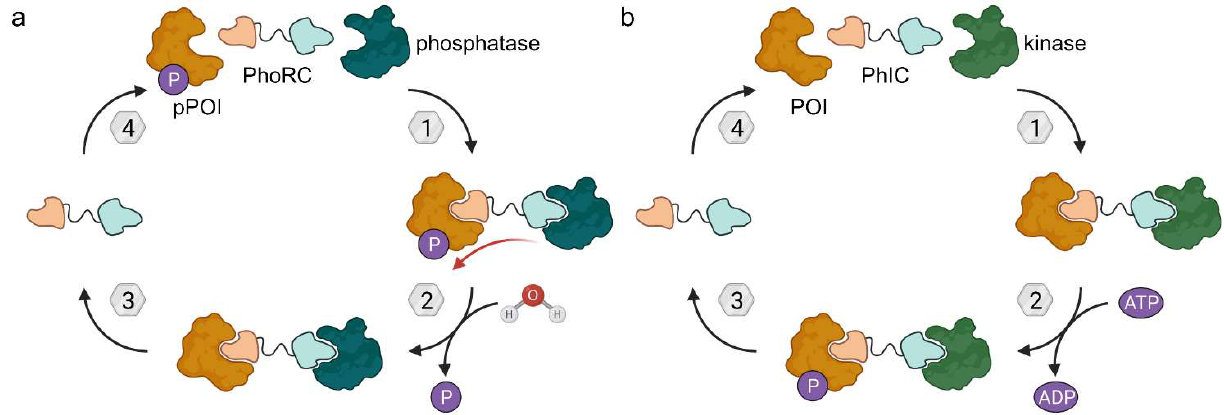
Figure 16. Phosphatase-recruiting chimeras (PhoRCs) and phosphorylation-inducing chimeras (PhICs). ( a ) PhoRCs are heterobifunctional molecules and bind the phosphorylated POI (pPOI) as well as a phosphatase. When the ternary complex forms, proximity enables the dephosphorylation of the POI. PhoRCs act catalytically unless the target proteins are bound irreversibly (covalently). ( b ) PhICs are the phosphorylating counterpart of PhoRCs and hijack kinases to phosphorylate their target consuming ATP.